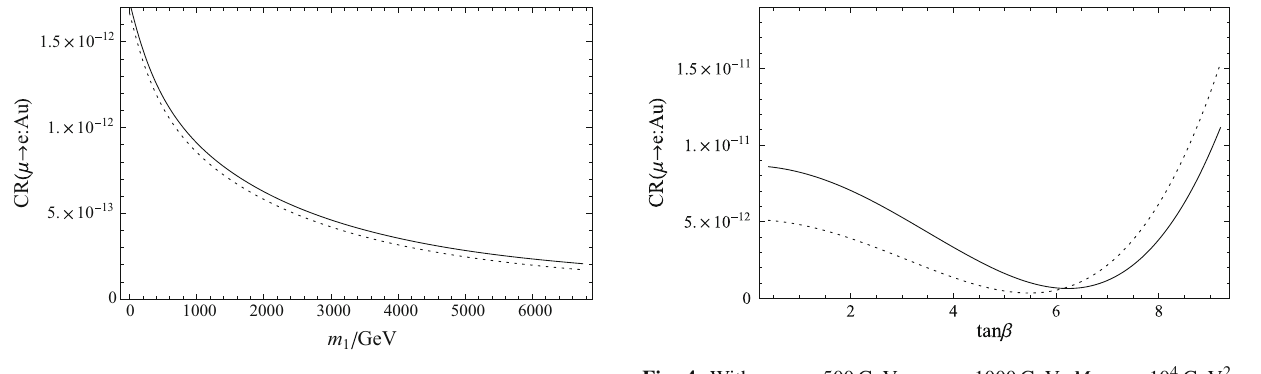
, the contribution to 6 = 12TeV 2 m